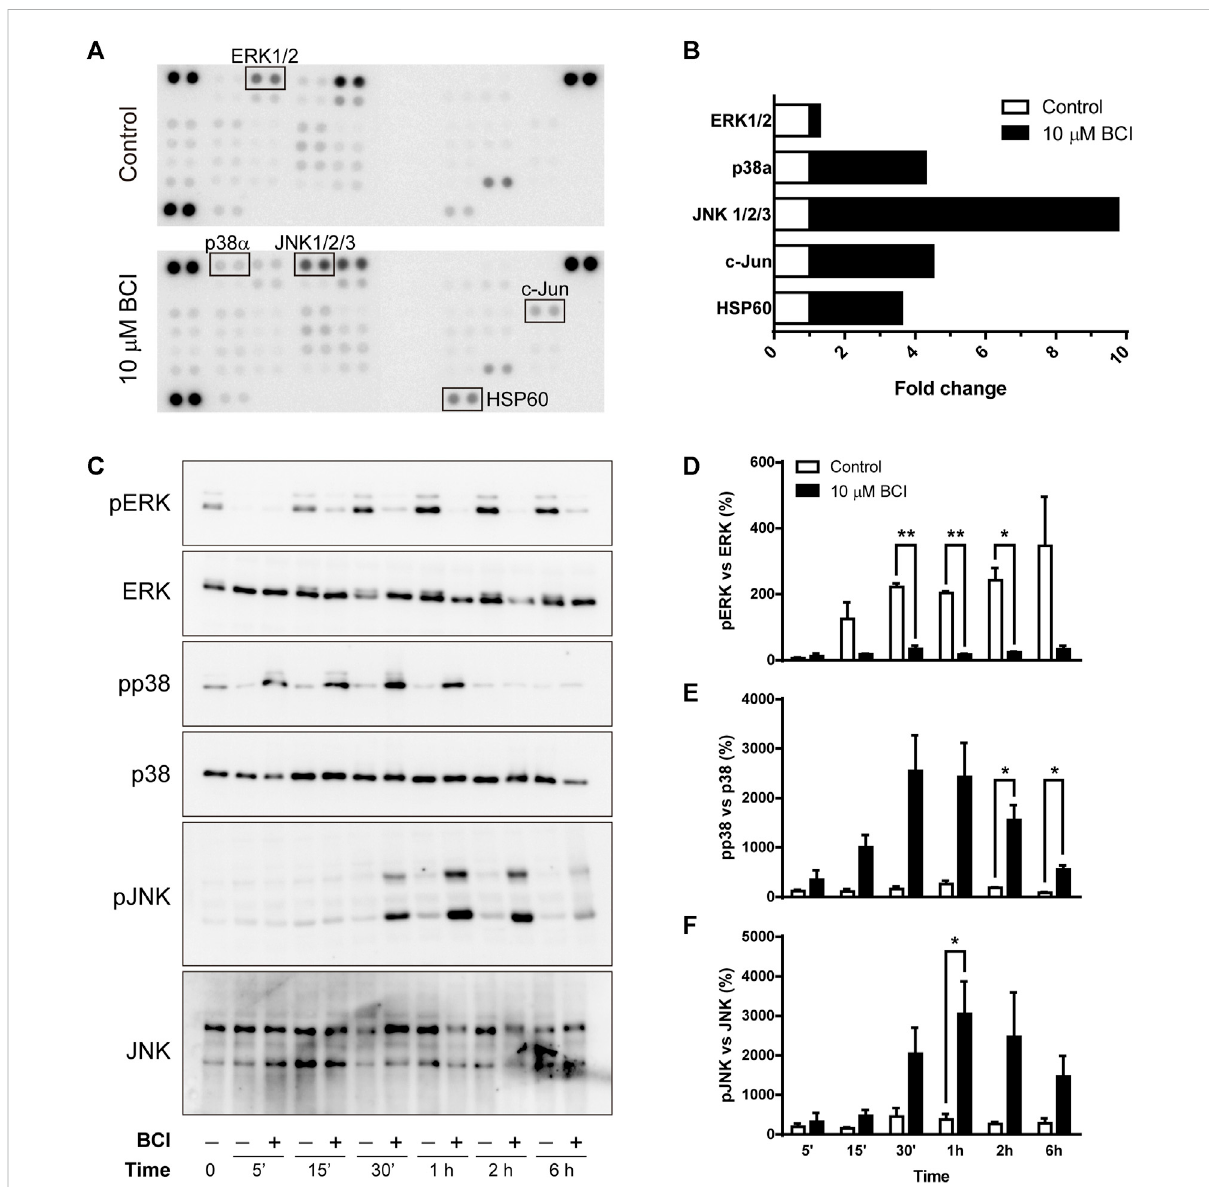
BCI affects the phosphorylation of MAPKs in neuroblastoma cells. (A) N2a cells were incubated in SFM for 1 h in the presence or absence (control) of BCI (10 μ M), and protein phosphorylation was analyzed with a Phospho-Kinase array assay. Phospho-epitopes that changed at least 2X following BCI treatment are shown in boxes. (B) Densitometry analysis of the array shown in panel A indicating the fold-increase of each phosphor- epitope. (C) N2a cells were incubated in SFM for 5 min, 15 min, 30 min, 1 h, 2 h or 6 h in presence or absence of BCI (10 μ M), with the cells cultured in complete medium shown as time 0. The cell extracts were resolved in immunoblots that were probed to detect the phospho- and total ERK,p38andJNKMAPKs.Thehistogramsrepresentphospho-ERK1/2 (D) ,phospho-p38 (E) andphospho-JNK (F) proteinincontrolandBCI-treated cells at the time points indicated and they were obtained by densitometry and normalized to the total ERK, p38 and JNK, respectively. Phospho- protein levels where normalized to those found in cells cultured in complete medium, set as 0%. The values represent the mean ± SEM of three independent experiments performed in duplicate. * p ≤ .05, ** p ≤ .01 vs.